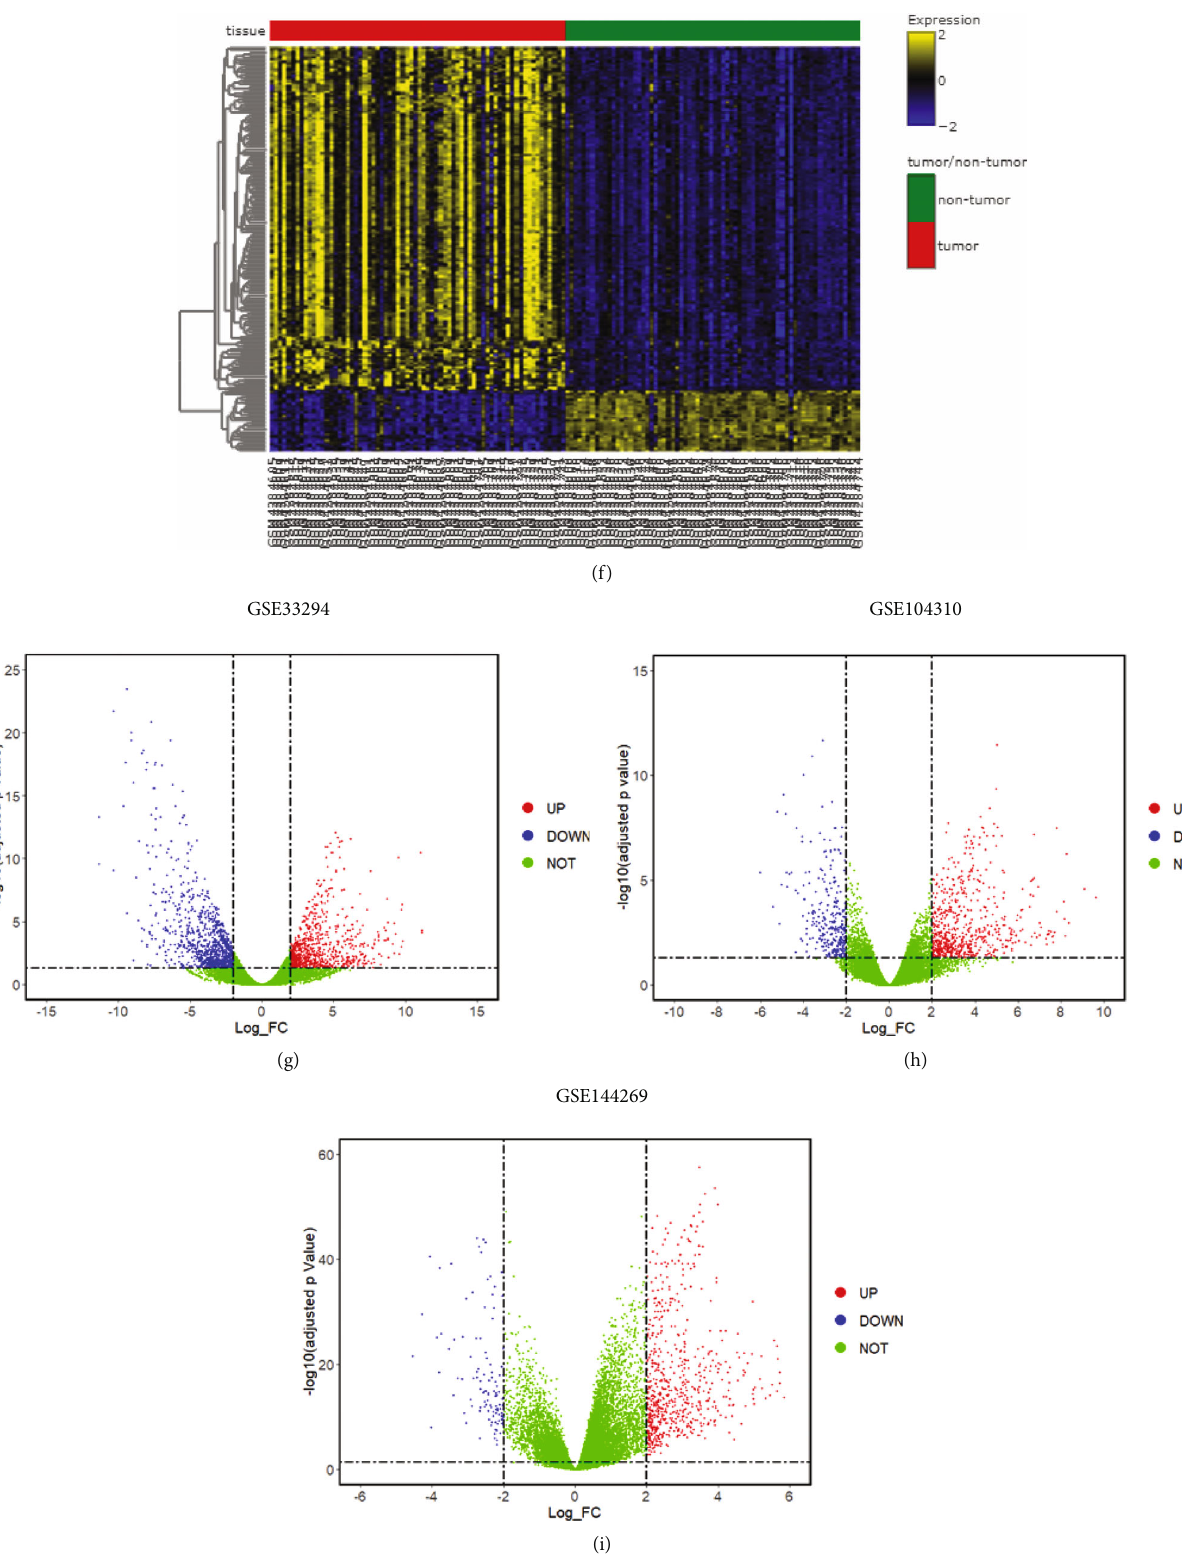
Figure 1: Analysis of DEGs from GSE33294, GSE104310, and GSE144269. PCA analysis of GSE33294(a), GSE104310(b), and GSE144269(c). Heatmap shows the DEGs ranked by adjusted P values in GSE33294(d), GSE104310(e), and GSE144269(f). Volcano plots of DEGs in GSE33294(g), GSE104310(h), and GSE144269(i). UP=signi fi cantly up-regulated genes; DOWN=signi fi cantly down-regulated genes; NOT=not signi fi cantly expressed